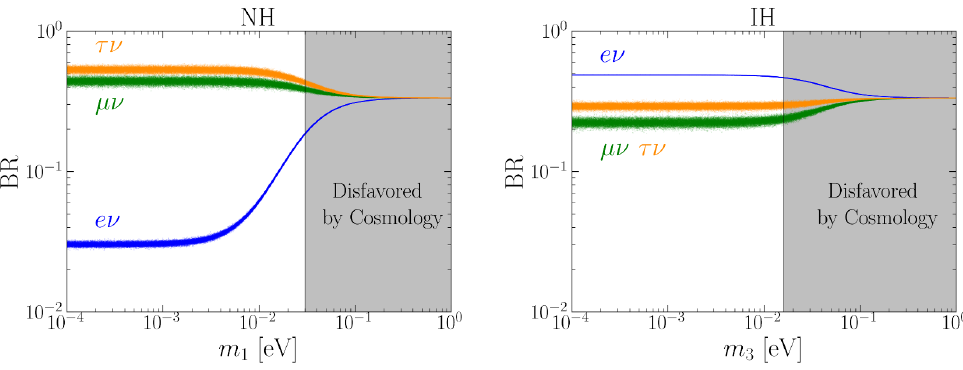
Figure 2 . Scatter plots for the H + decay branching ratios to leptons versus the lowest neutrino mass for NH (left) and IH (right) with Φ on the lightest neutrino mass m collaboration [114].